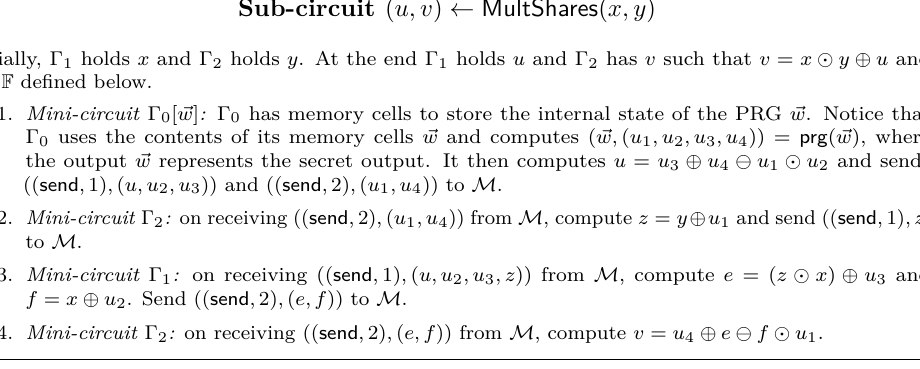
Figure 14: The computation of the gates by the mini-circuits (Γ 0 , Γ 1 , Γ 2 ). All operations are field operations in the underlying field F . The MultShares circuit is called in the field multiplication operation, where the latter is also shown in Figure